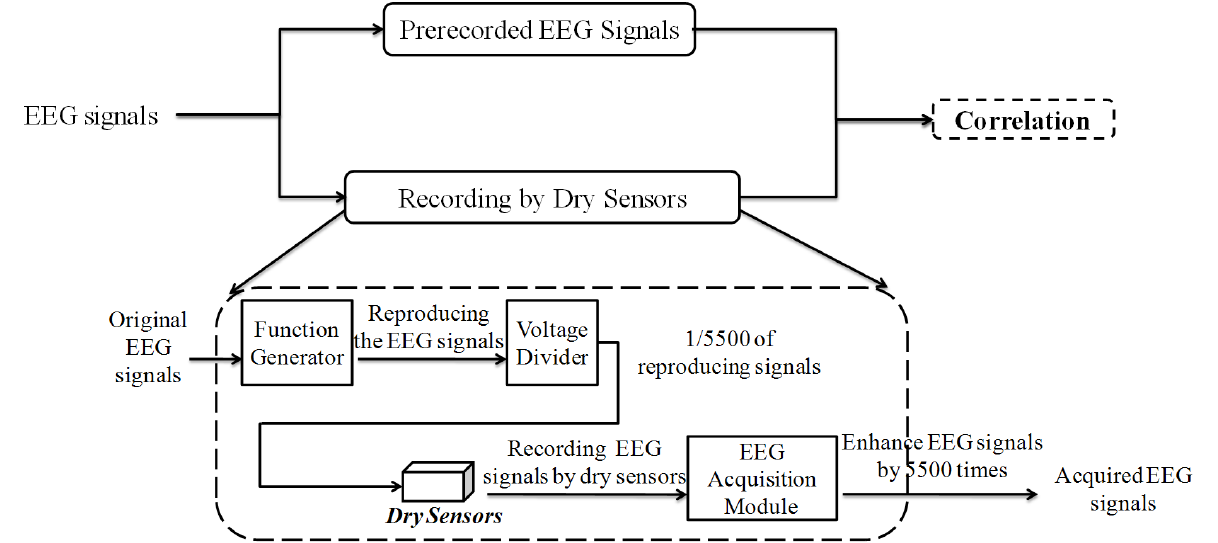
Figure 7. Experimental process for signal quality assurance of the dry sensors.